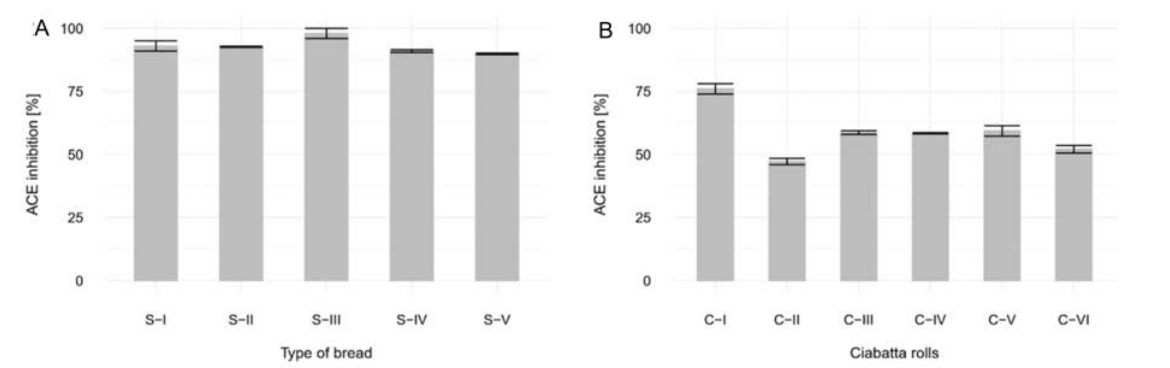
Figure 2. ( A ). Percentage of angiotensin-converting enzyme (ACE) inhibition in di ff erent types of sourdough bread compared to yeast bread, for which inhibition is equal to 0%. Results of ANOVA test p > 0.05. ( B ). Percentage of ACE inhibition in di ff erent types of ciabatta rolls after digestion compared to yeast bread, for which inhibition is equal to 0%. Results of ANOVA test p >